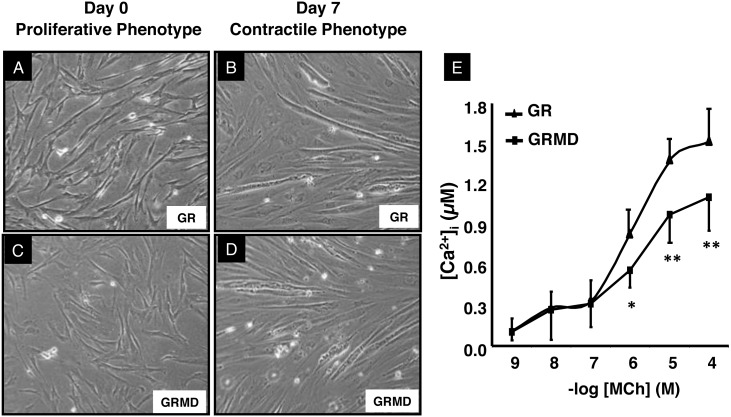
Dystrophin loss affects intracellular Ca2+ release by contractile agonist.Primary tracheal smooth muscle cells were grown to confluence from normal golden retriever (GR) and golden retriever muscular dystrophy (GRMD) animals and then were serum starved in F12+ITS (1%) containing media to induce a contractile phenotype in culture. Phase contrast pictures were taken at day 0 (proliferative phenotype) for GR (A) and GRMD (C) and later at day 7 (contractile phenotype) for GR (B) and GRMD (D). Images are representative of at least 6–9 different primary myocyte cultures obtained from 3 normal (GR) and dystrophic (GRMD) animals. (E) Representative tracings from experiments using Fura-2 loaded airway smooth muscle cells (GR and GRMD) grown to confluence then serum-deprived in insulin-supplemented media for 7 days. Cells were first stimulated with methacholine (MCh: 10−9 to 10−4 M) and changes in intracellular Ca2+ ([Ca2+]i) recorded. Concentration-response curves for MCh were plotted as peak [Ca2+]i. Curves are derived using individual data points that are the mean ± SEM of at least 40–45 cells in total (assayed in at least three different experiments). Statistical comparisons shown were performed by 1-way ANOVA with Tukey’s multiple comparison test. *p<0.05, **p<0.01 at a given MCh concentration.